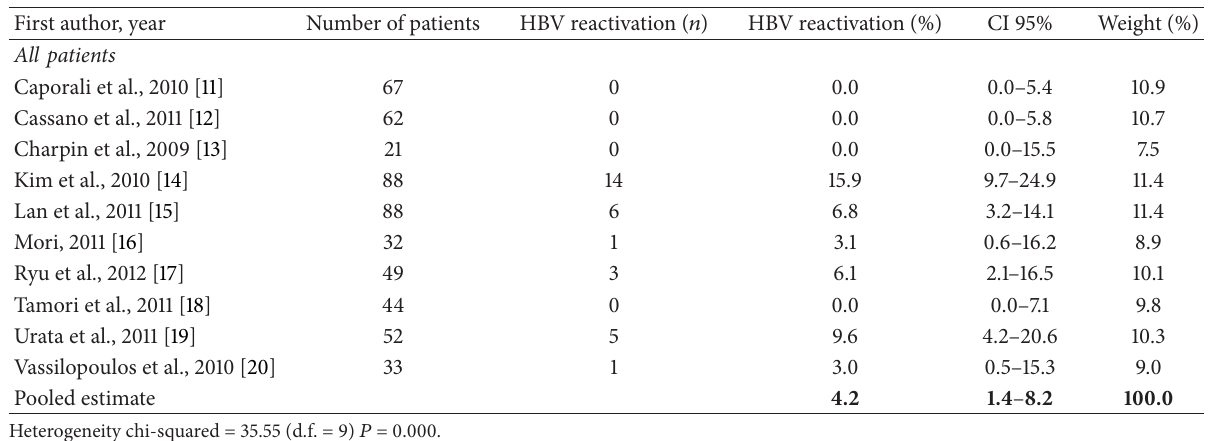
Table 2: Meta-analysis of the prevalence of HBV reactivation among patients treated with biologic agents.